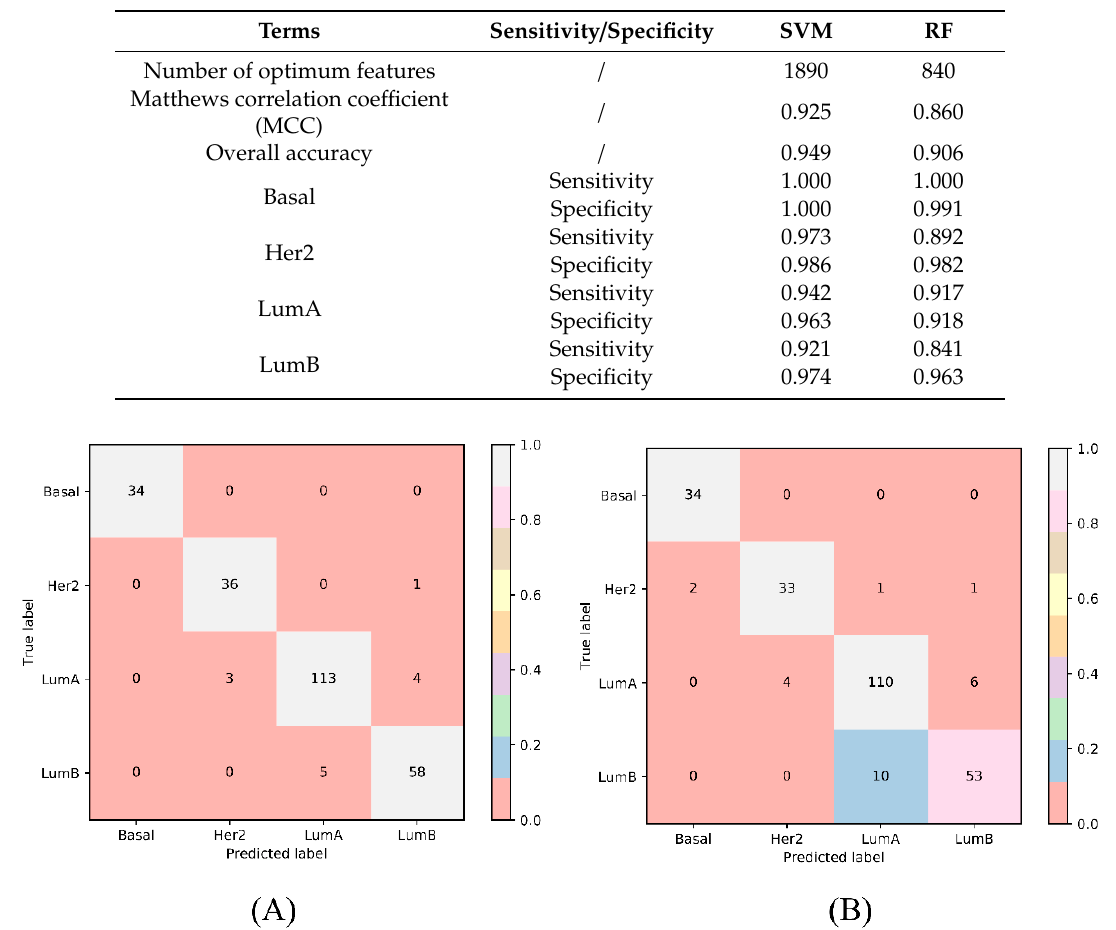
Table 1. Performance and optimum number of features of incremental feature selection (IFS) with support vector machine (SVM) and random forest (RF).